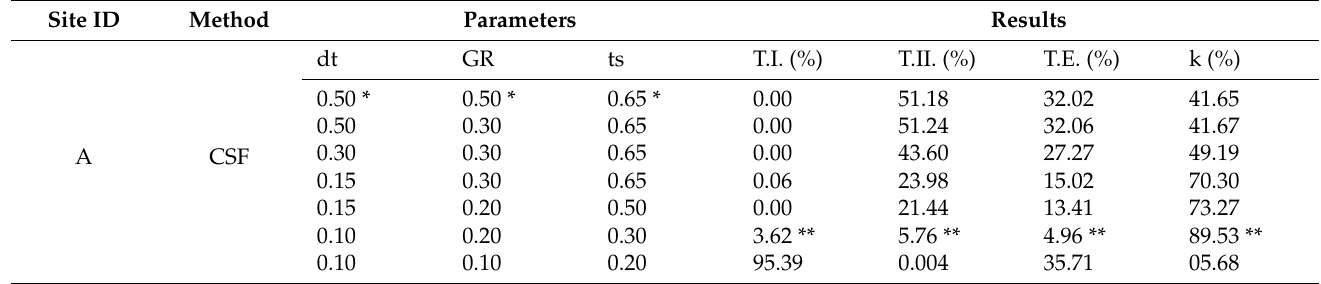
Table 4. CSF ground classification error metrics and kappa coefficients for different parameter values.